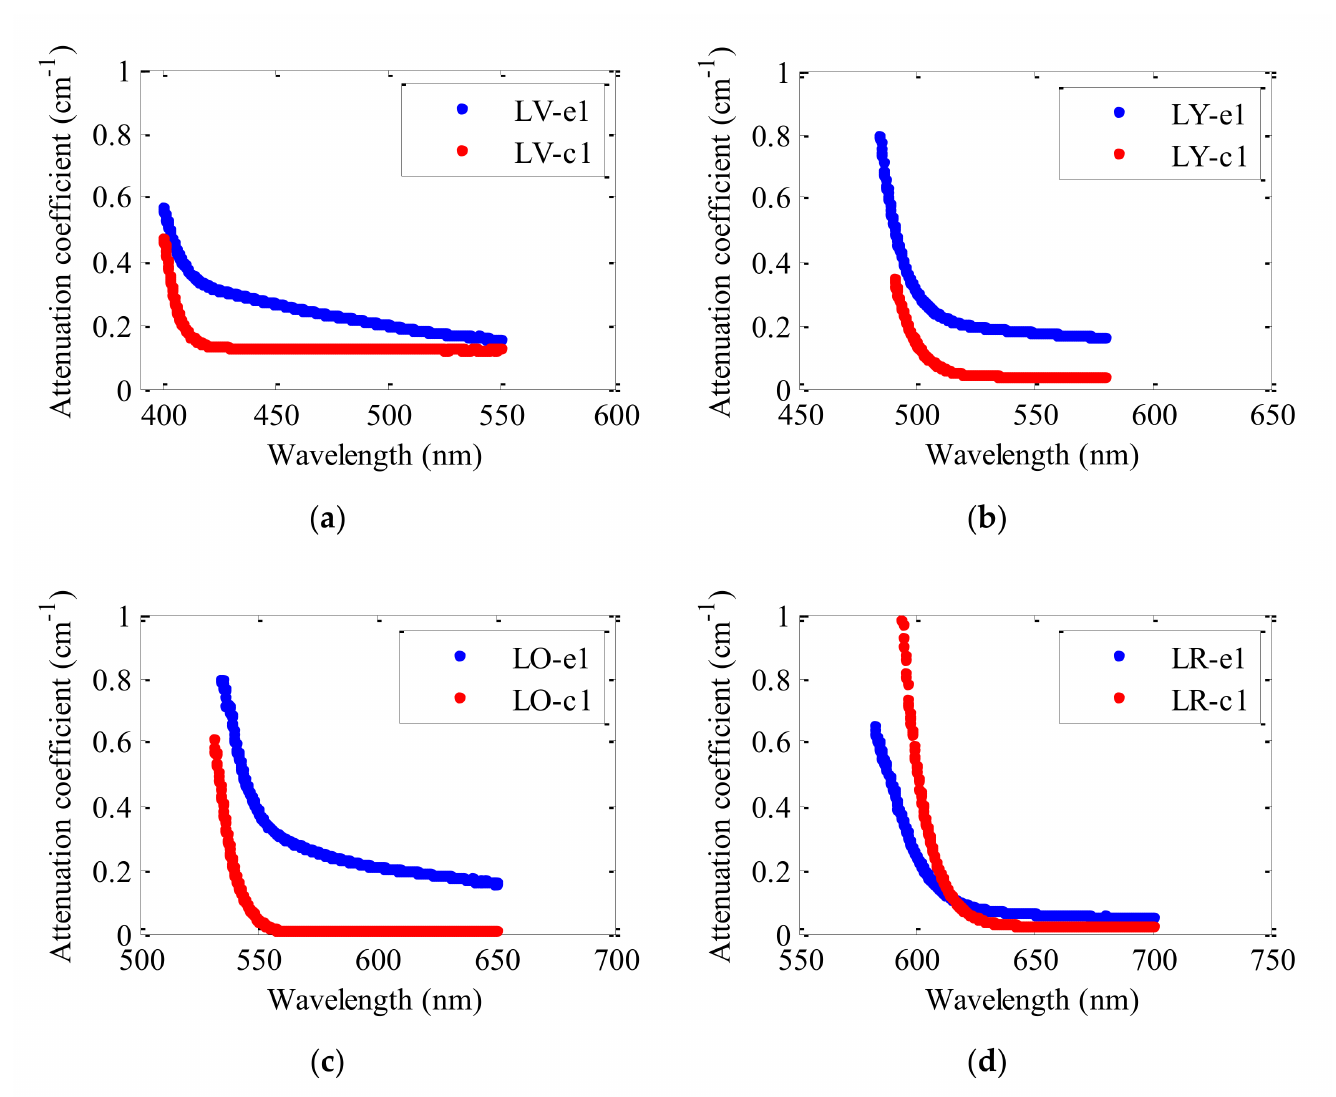
Figure 6. Attenuation coefficients for ( a ) LV, ( b ) LY, ( c ) LO and ( d ) LR doped fibers made by extrusion method (blue curves) and for those made by the casting one (red curves). All the fibers have the same dye concentration (0.003 wt%). The excitation irradiance was 22 nJ · cm − 2 at 520 nm with z e = 1.2